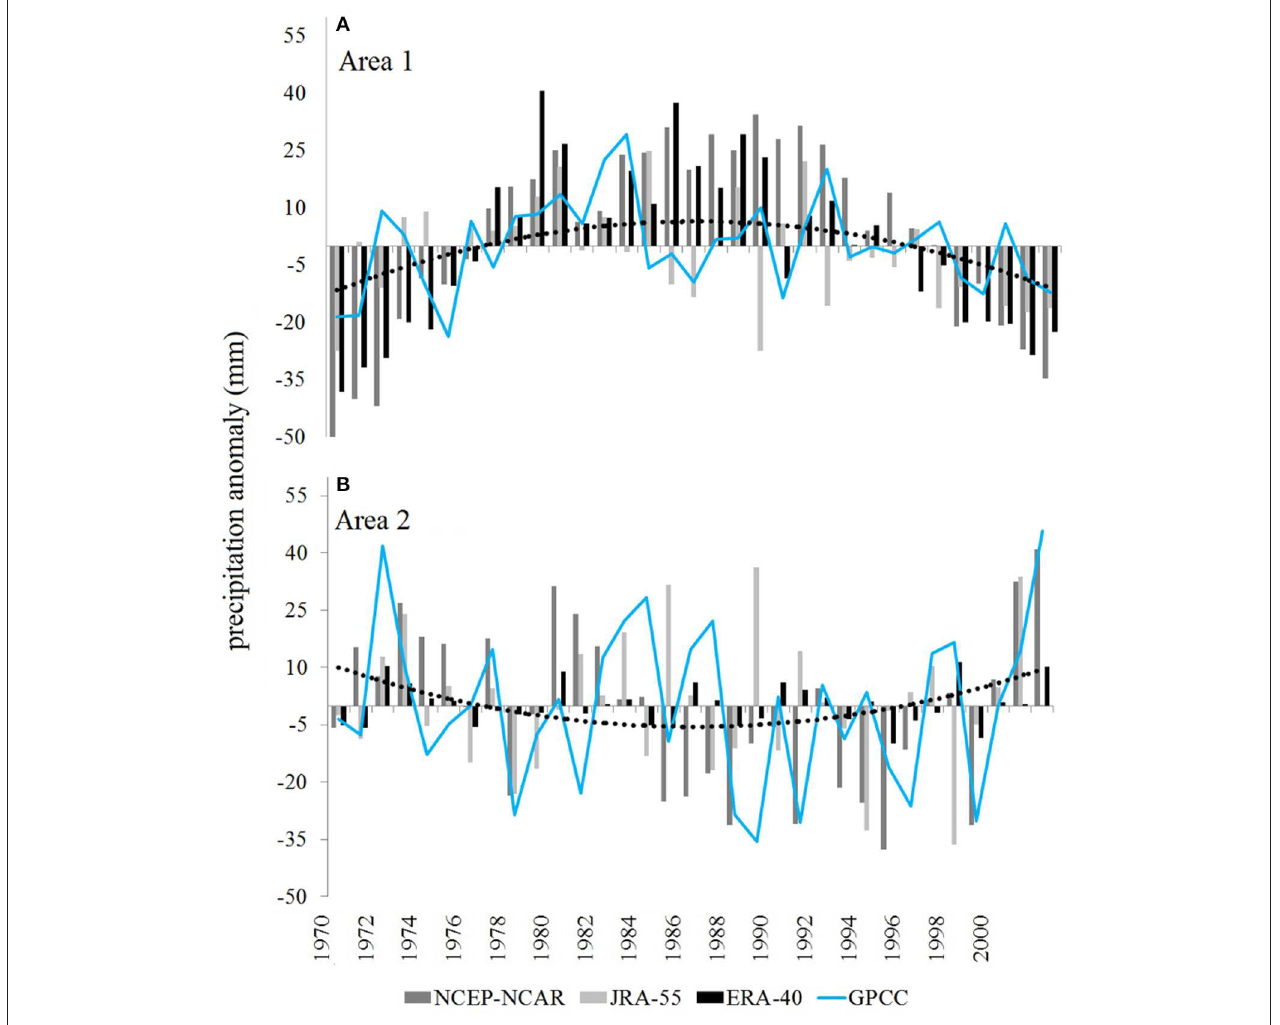
FIGURE 9 | Temporal evolution of precipitation anomaly from GPCC (blue line) dataset, NCEP-NCAR reanalysis I (gray bar), JRA-55 (light gray bar), and ERA-40 (black bar) reanalysis data for the 1970–2001 period, for areas (a) A1 and (b) A2 as in Figure 8 . Polynomial of degree two for the GPCC data is represented by dotted